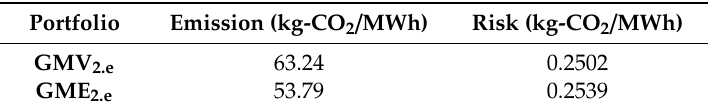
Table 6. Emission and risk of the global minimum variance (GMV) and global minimum emission (GME) portfolios of model